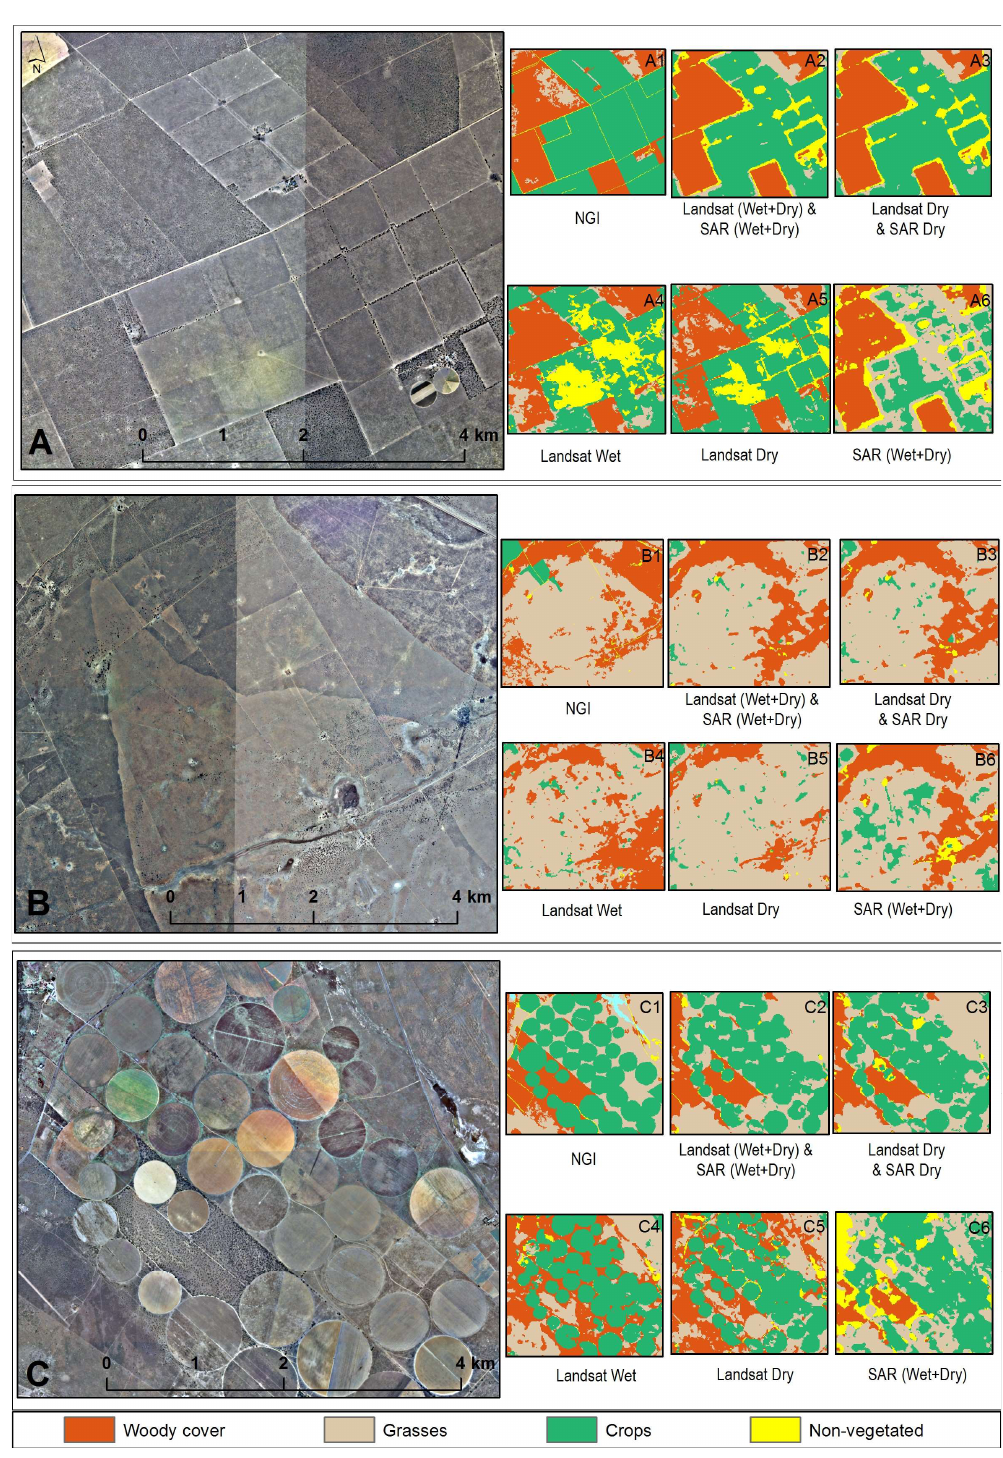
Figure 7. Example subsets from the study area depicting: ( A – C ): the aerial imagery; ( A1 , B1 , C1 ): the NGI 2010 land cover map [43]; and ( A2 – A6 , B2 – B6 , C2 – C6 ): classification model results of this study.